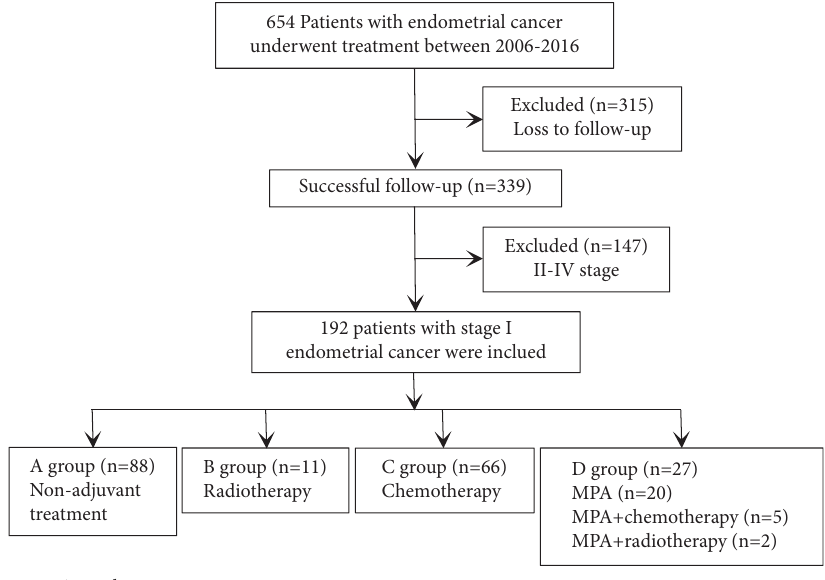
Figure 1: Retrospective study fow